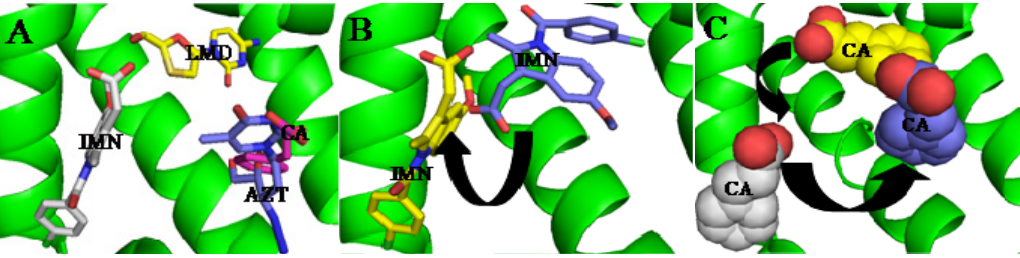
Figure 4. ( A ) Structural basis of IMN–CA–LMD co-binding to subdomain IIA of HAS; ( B ) the reposition route of IMN in the presence of CA and LMD; ( C ) the reposition route of CA in the presence of IMN and IMN–LMD. Dashed line (red), hydrogen